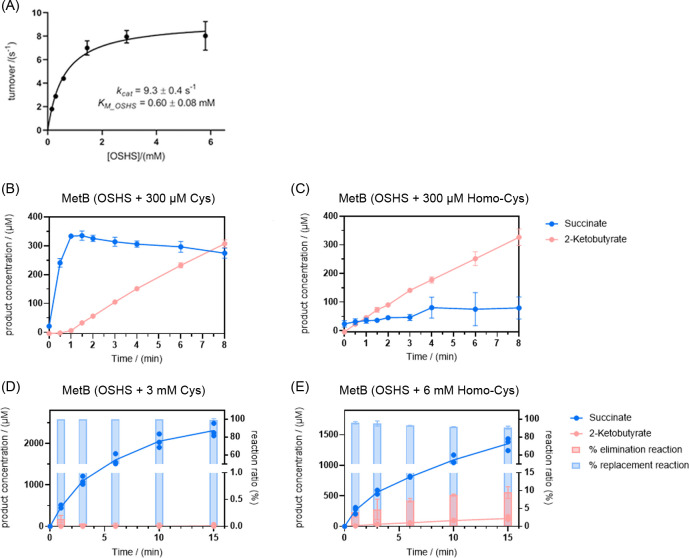
MetB catalyzes O-succinyl-L-homoserine (OSHS) cleavage to generate 2-ketobutyrate (2 KB).(A) Kinetics of OSHS cleavage by MetB. (B) Formation of 2 KB is suppressed by the addition of cysteine (Cys, 300 µM) and (C) to a much lesser extent by the addition of homocysteine (Homo-Cys, 300 µM). The same phenomenon is observed at much higher concentrations of cysteine (Cys, 3 mM – Panel D) and full homocysteine-dependent repression can be observed at concentrations of this magnitude (Homo-Cys, 6 mM – Panel E). Error bars correspond to standard deviations. Note: MetB can perform two separate replacement reactions: either with cysteine as co-substrate (black arrow, Figure 5) or with homocysteine as co-substrate (reaction 2, Figure 5). To visualize the elimination (reaction one in Figure 5) and replacement reactions, the succinate concentrations shown here account for the succinate generated exclusively from the replacement reaction and are calculated by subtracting the concentration of 2 KB (which is stoichiometrically 1:1 with the concentration of succinate generated by the elimination reaction) from the total concentration of succinate. Effectively, succinate shown in panels B–E is exclusively the product of the replacement reaction 2 in Figure 5. The bar charts in panels D and E represent the extent to which the elimination and replacement reactions contribute to the overall catalytic turnover of MetB.